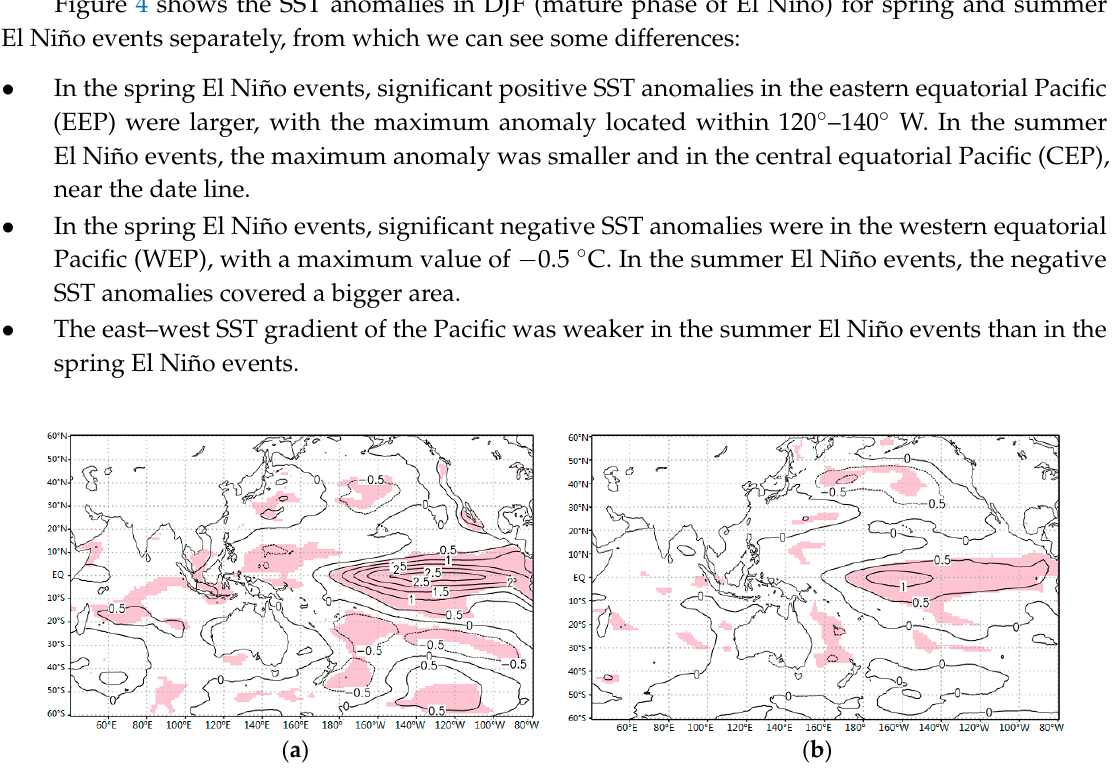
Figure 4. Composites SST anomalies (units: °C) during DJF 1979–2016 for ( a ) spring and ( b ) summer El Niño events. The contour interval is 0.5 °C. Shaded areas are statistically significant at the 95% confidence level, based on the Student’s t -test.